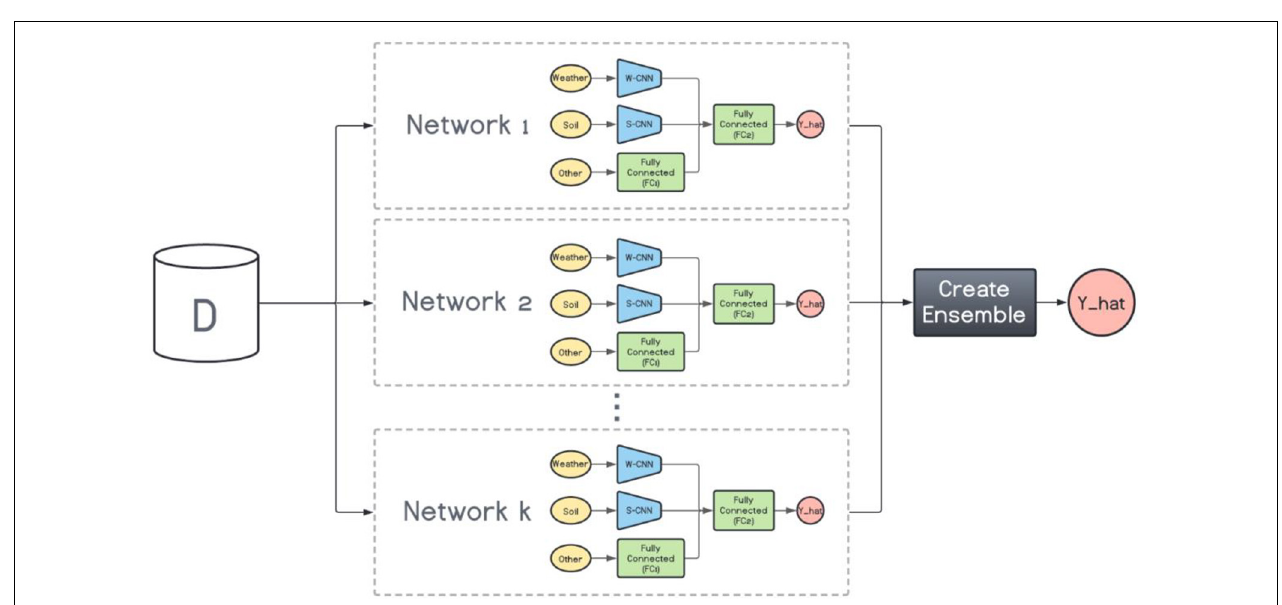
FIGURE 2 | Homogenous ensemble creation with bagging architecture. k data sets (D1, D2, ... , Dk) were generated with bootstrap sampling from the original data set (D) and the same base network is trained on each of them. The ensemble creation combines the predictions made by the base networks.